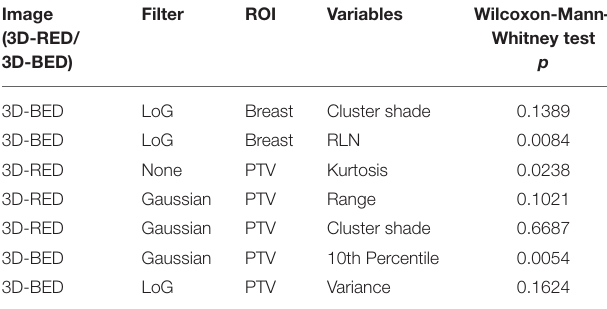
the subset of variables in the data set resulting in the smallest model with lowest prediction error (25).